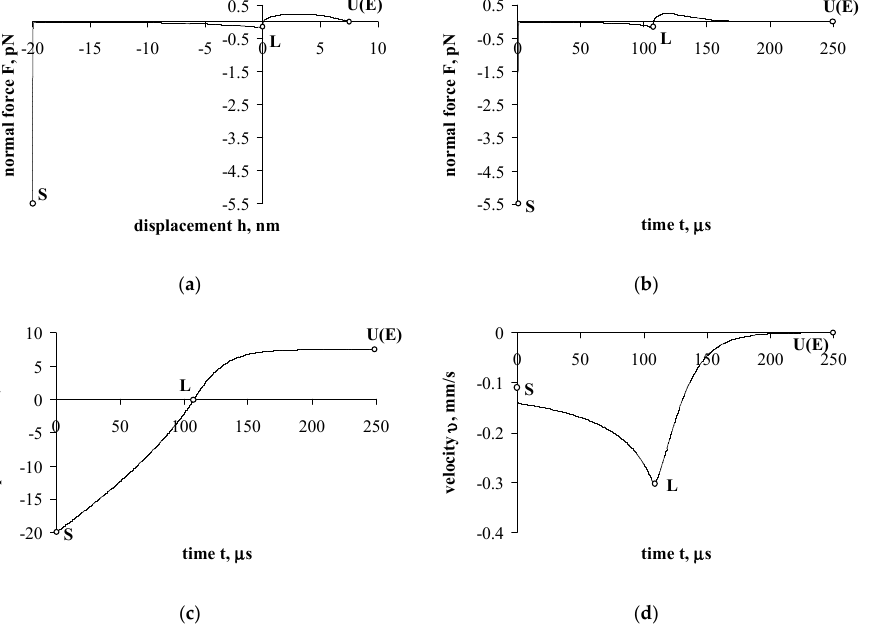
Figure 3. Interaction of an erythrocyte with a blood clot (fibrin and platelets) with drag force. Dependence of the normal force on displacement ( a ) and time ( b ); dependence of displacement ( c ) and velocity ( d ) on time.